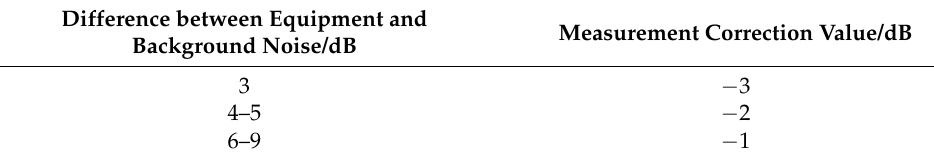
Table 2. Correction of background noise.